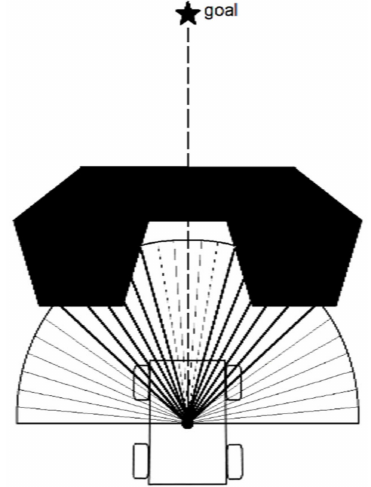
Figure 4. The case of the local-minima